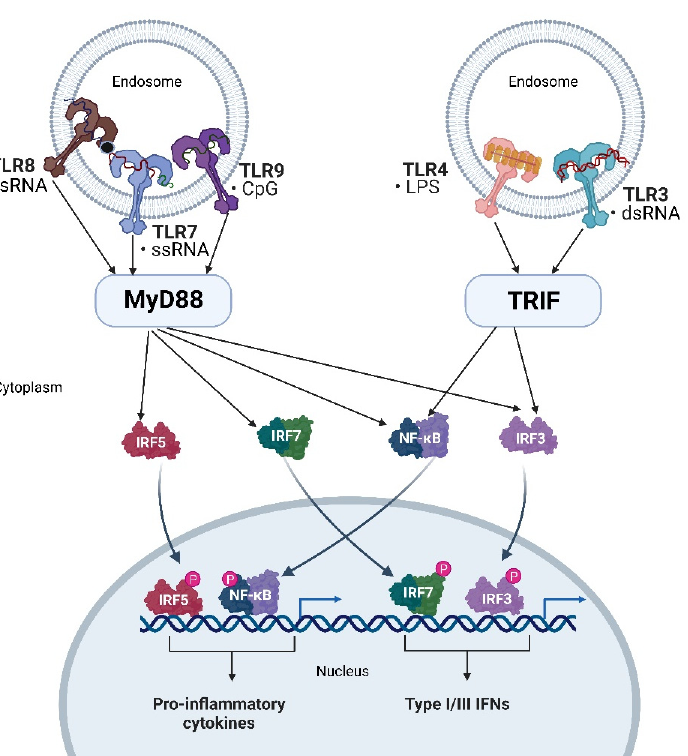
Figure 1. Schematic illustration of TLRs localized to endosomes and the downstream signaling path- ways modified from [57]. The expression pattern of endosomal TLRs differs between different cell types and there are also species variations as well as differential up- and downregulation in re- sponse to danger signals. TLR4 can localize both to the plasma membrane and the endosomes de- pending on the cell type in response to ligands such as LPS. TLR3 recognizes dsRNA, TLR7 recog- nizes ssRNA on one binding site combined with binding to guanosine on the other site, while TLR8 recognizes ssRNA combined with binding to uridine. TLR9 responds to unmethylated CpG motifs that are present at high frequency in bacteria. TLR signaling begins once ligand binding has induced receptor dimerization, which is followed by the engagement of the TIR domain-containing adaptor proteins TRIF (right) or MyD88 (left). The engagement of adaptor proteins will initiate downstream signaling cascades which will lead to phosphorylation and nuclear translocation of transcription factors encoding for proinflammatory cytokines or type I and III interferons. Created with BioRen- der.com. Foreign nucleic acids are specifically recognized by RLRs, cytosolic DNA sensors, and a subgroup of TLRs [57]. The subgroup of TLRs that can recognize nucleic acids con- sists of TLR3, 7, 8, and 9, which all primarily reside in endosomal compartments unlike other nucleic acid sensors, which are found in the cytosol. In general, these TLRs can sig- nal from endosomes by binding to structures that are only accessible once they are taken up and degraded or part of a virus utilizing a certain endocytic pathway to enter the cell. Notably, each endosomal TLR recognizes a specific type of nucleic acid [57]. TLR3 recognizes dsRNA after uptake through clathrin-mediated endocytosis [62]. The sources of dsRNA recognized by TLR3 have been reported to be long dsRNA [63,64]